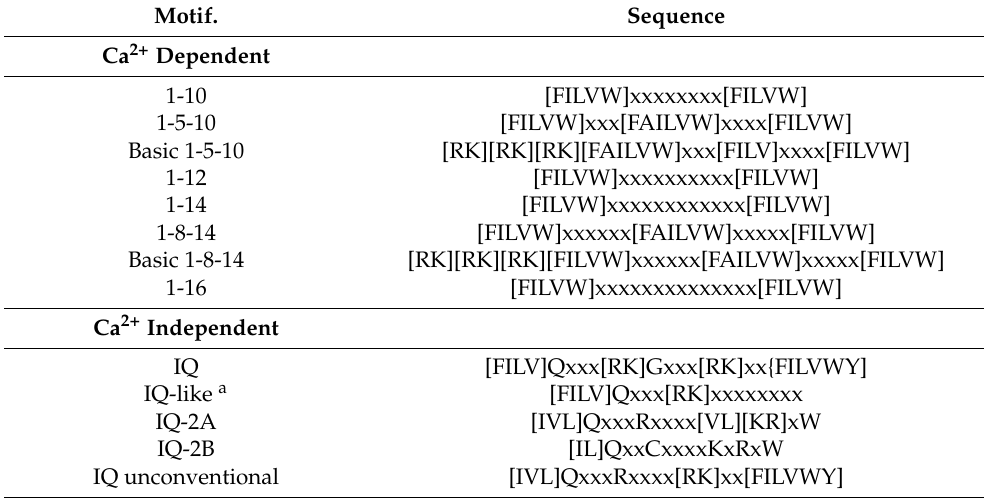
Table 1. CaM-Binding Motifs.